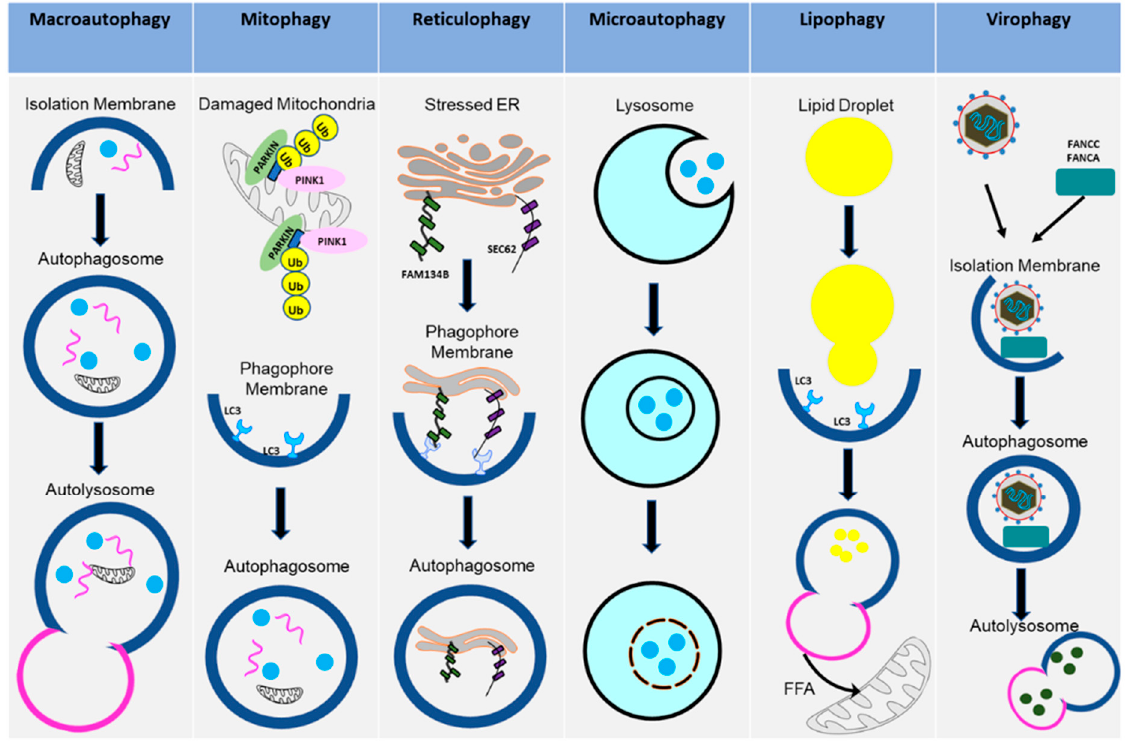
Figure 2. Various types of autophagy pathways. The diagram shows how the cells activate different types of autophagy pathways in the uninfected or the virus-infected cells. These pathways contribute to cellular homeostasis or disease states.